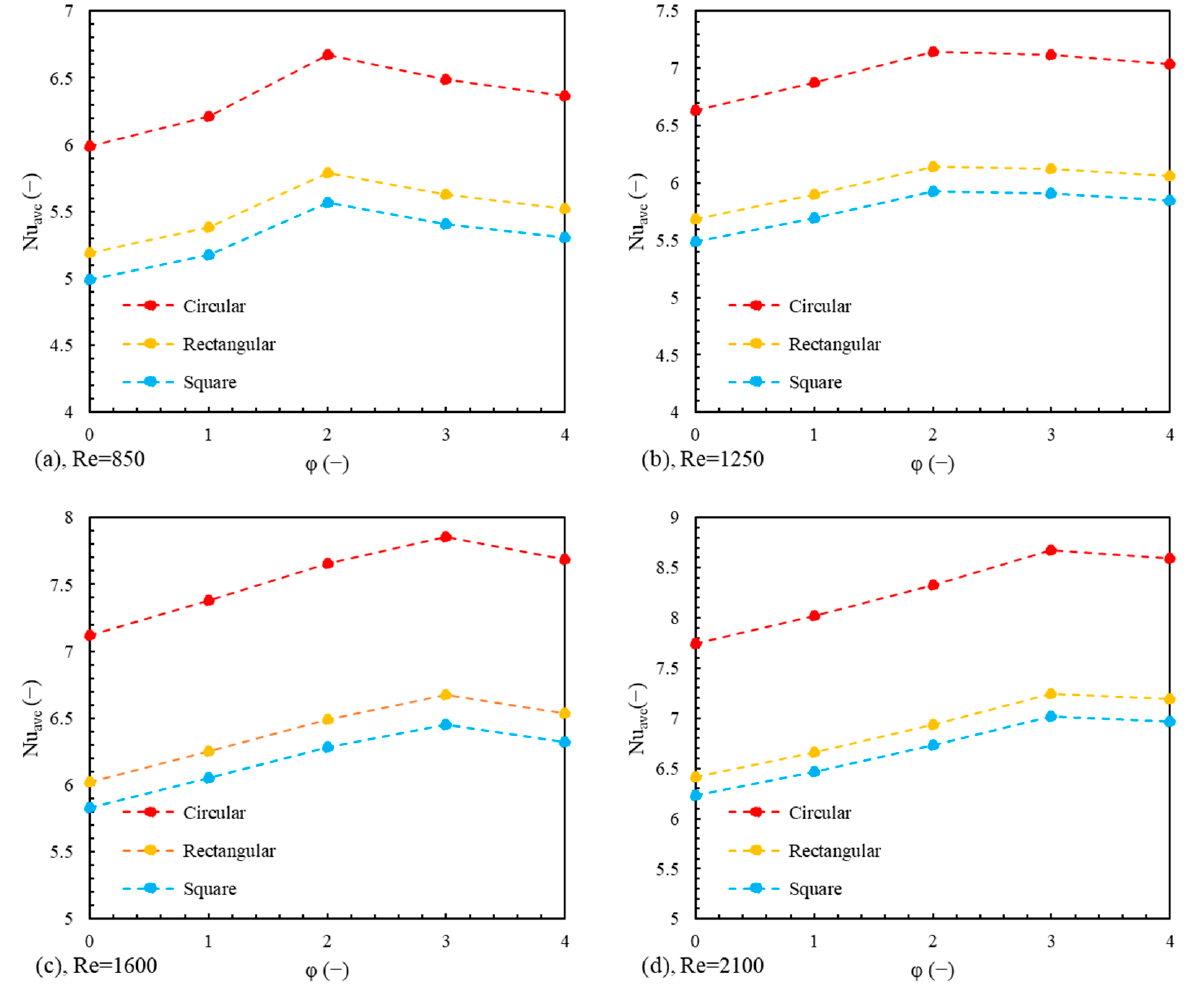
Figure 11. The average Nu number for all cross-sections in different fluid flows in ( a ) Re = 850, ( b ) Re = 1250, ( c ) Re = 1600, and ( d ) Re = 2100.